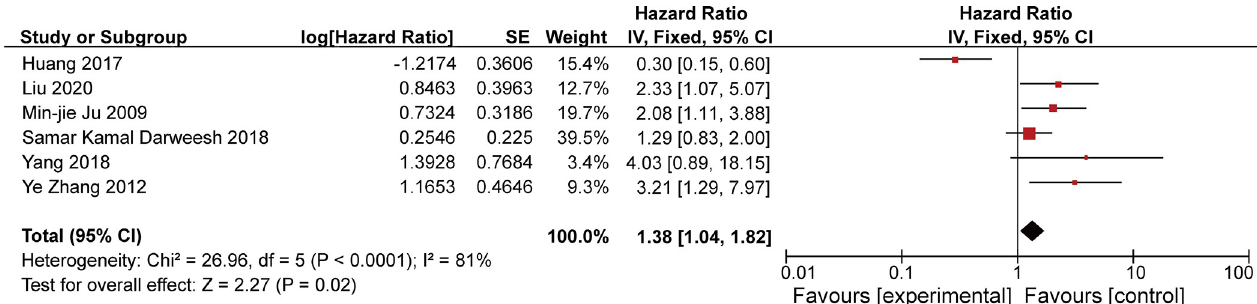
Fig 3. Forest plot showing the correlation between change in overall survival and secreted protein acidic and rich in cysteine expression in patients with hepatocellular carcinoma.